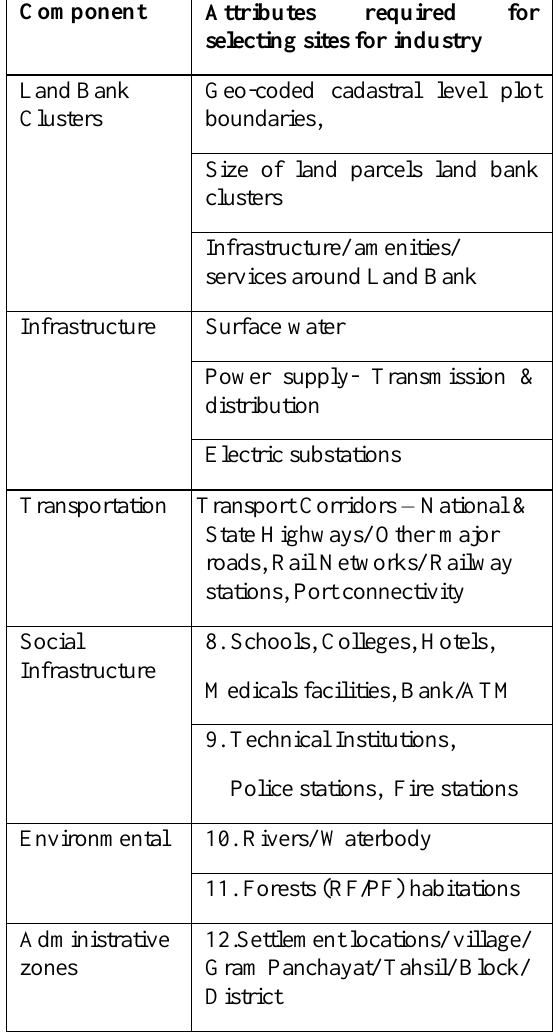
Table 1. List of Database developed for the